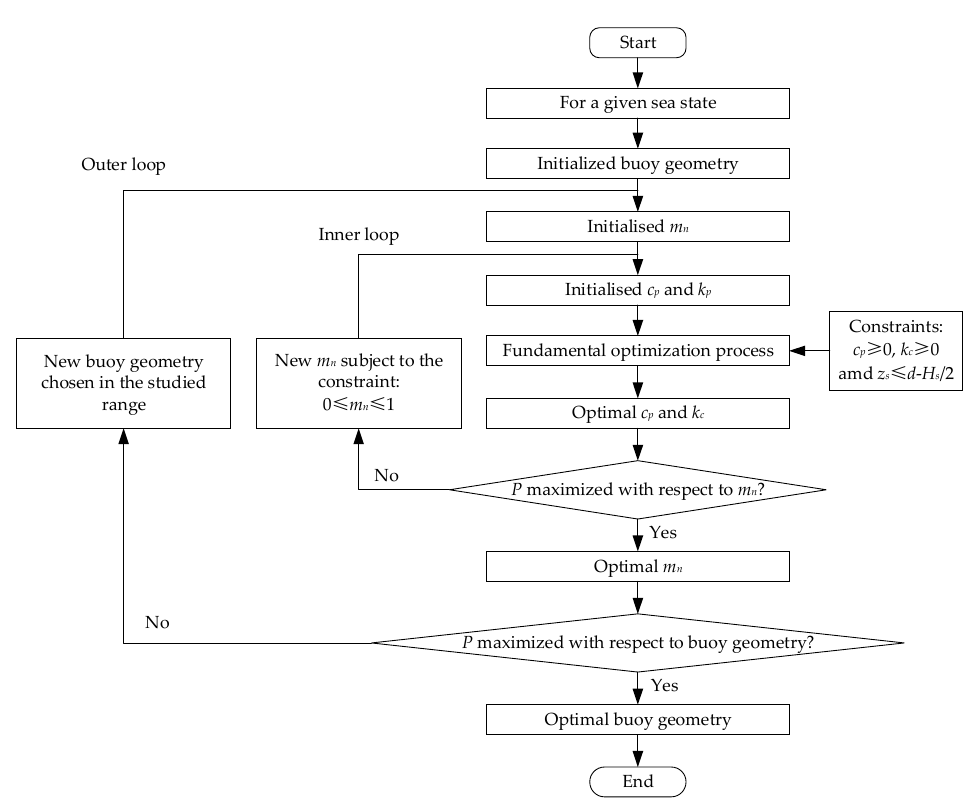
Figure 4. The flowchart of solving the optimization problem.